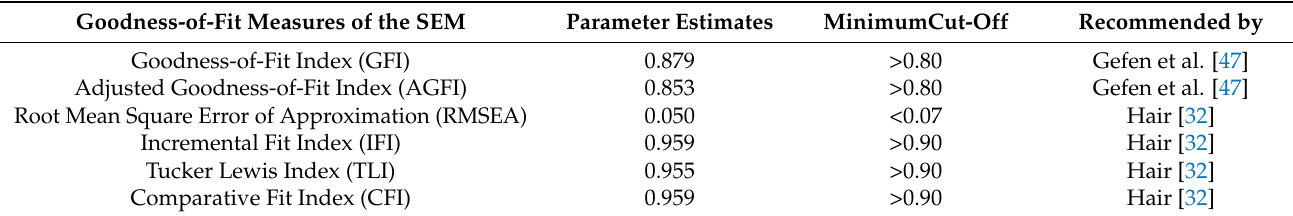
Table 4. Model fit.